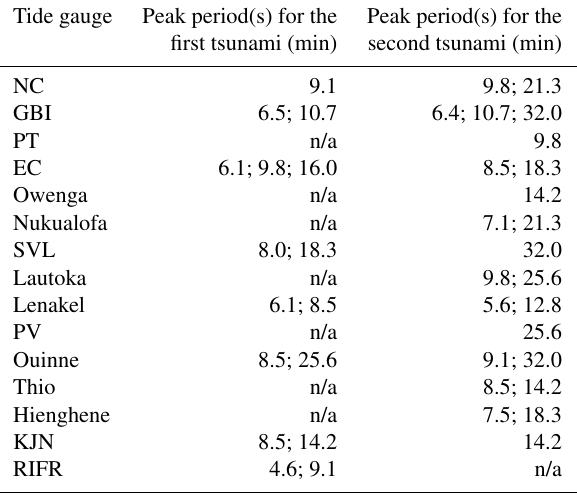
Table 1. Peak periods at each tide gauge for two tsunami events. The values were calculated by Fourier analyses. Station name ab- breviations are North Cape (NC), Great Barrier Island (GBI), East Cape (EC), Suva Viti Levu (SVL), Kingston Jetty Norfolk (KJN), Port Vila (PV), and Raoul Island Fishing Rock